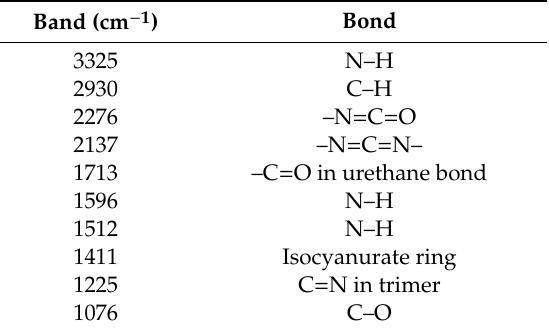
Table 6. Results of FTIR analysis.